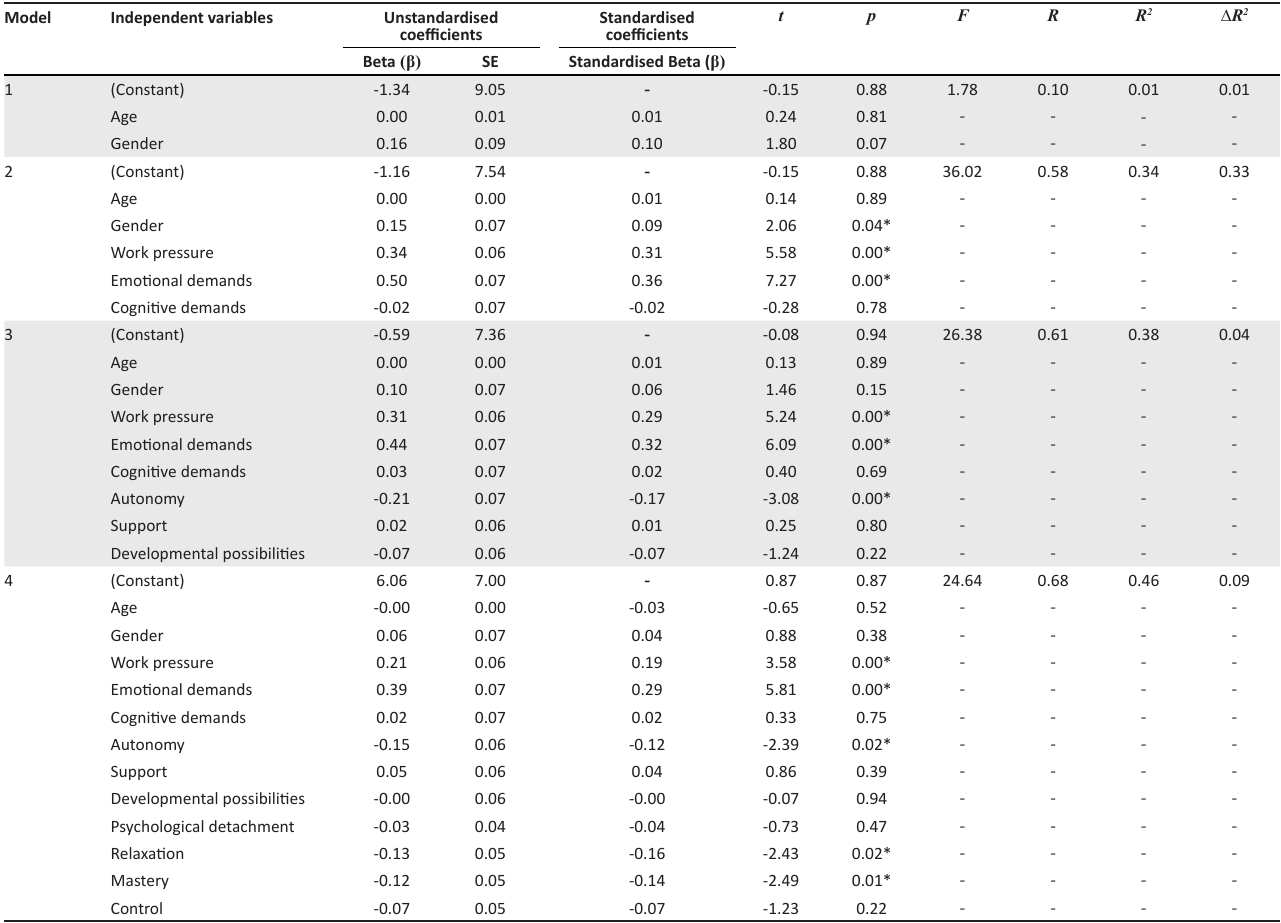
TABLE 2: Multiple regression analysis with work-parent interference as dependent variable.